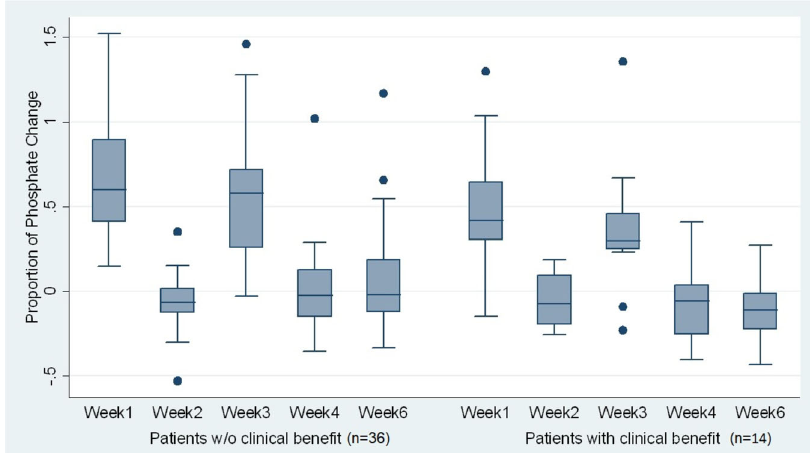
Fig. 1 Boxplots of phosphate changes, showing the proportion of phosphate change at different time points using cycle 1 day 1 phosphate as baseline. Two patients without follow-up data are not included in the graph. The centre lines are de fi ned by the median. The ‘ outsider ’ dots are the data points that fall outside the line called “ whiskers ” in the boxplot. The whiskers include all data points within 1.5 IQR (Interquartile range) of the nearer quartile (e.g. 3rd Quartile or 75th percentile). Source data are provided as a Source Data fi